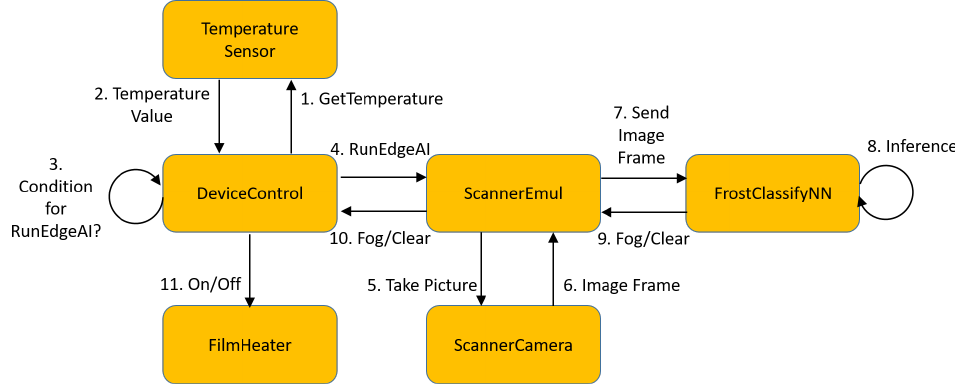
Figure 7. System state